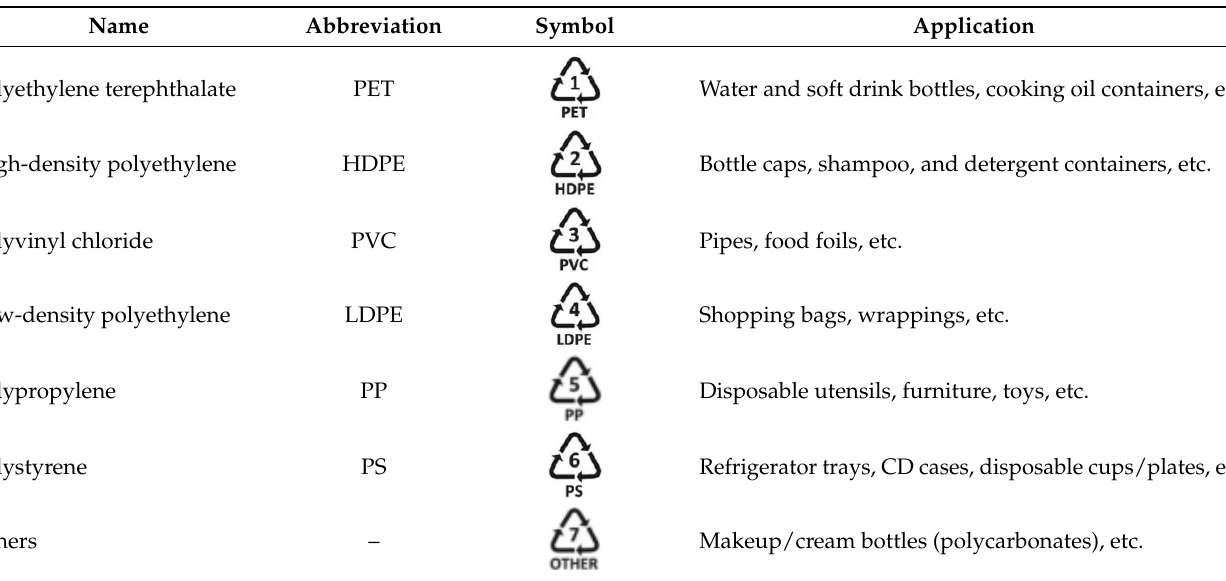
Table 1. Plastic types used in the study and their typical technical applications.